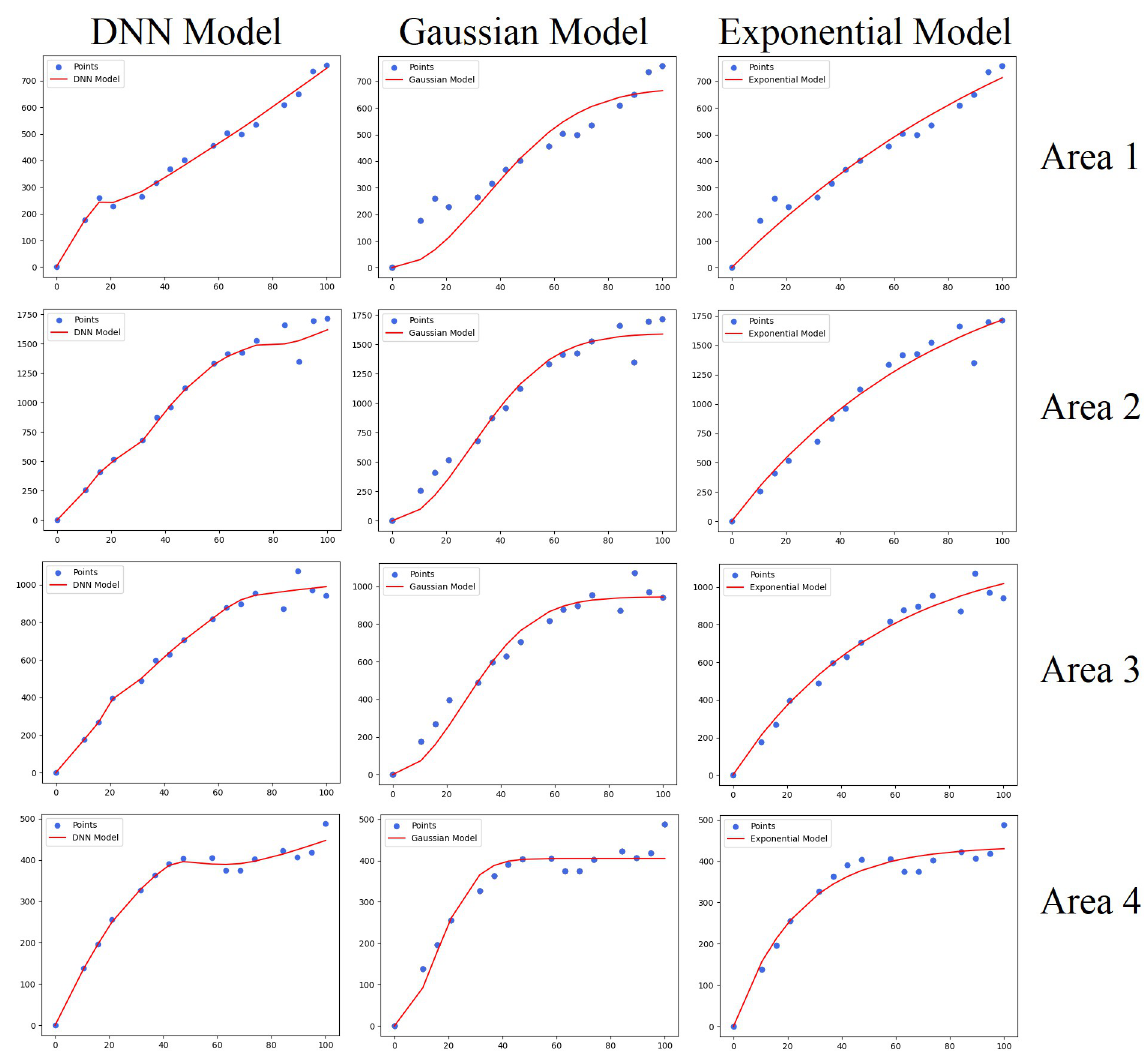
Fig 4. Validation of sample normal distribution in the four